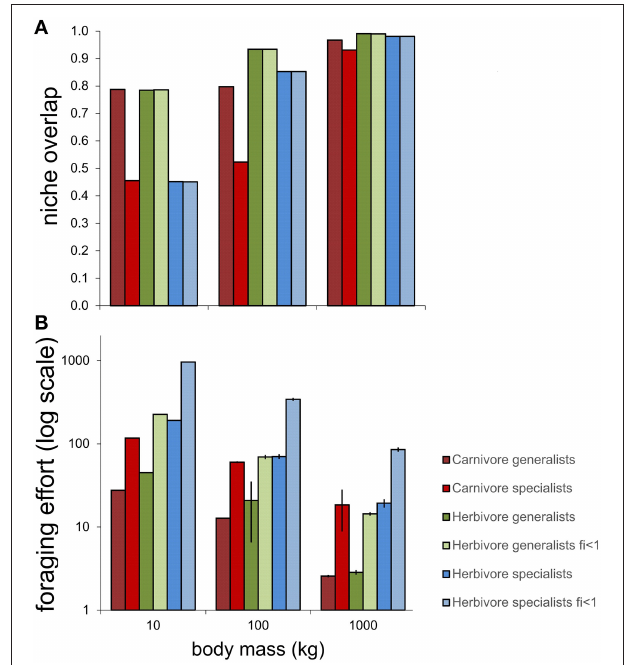
FIGURE 1 | Simulated patterns of (A) average niche overlap between individuals and (B) average foraging effort of individuals, within populations of mammal carnivores, and herbivores of different body sizes. Niche overlap is calculated using Pianka’s (1986) index; foraging effort is estimated as the number of foraging bouts required for individuals to achieve intake requirements. Generalists are defined as populations in which individuals consume any prey item they encounter, specialists as populations in which individuals consume prey of only one type. The parameter f i represents the fraction consumed by herbivores of each food item encountered; for cases where f i < 1 then f i = 0.2. Bar heights depict means, and error bars are 95% confidence limits, over 1000